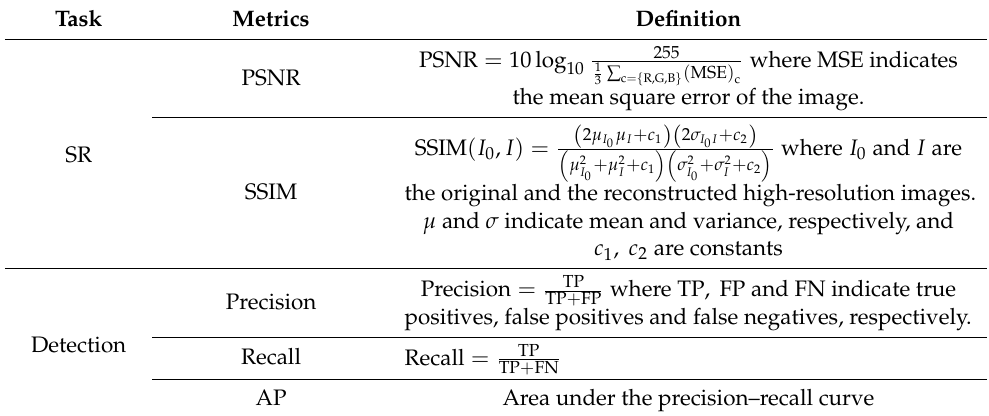
Table 1. The definition of utilized quantitative